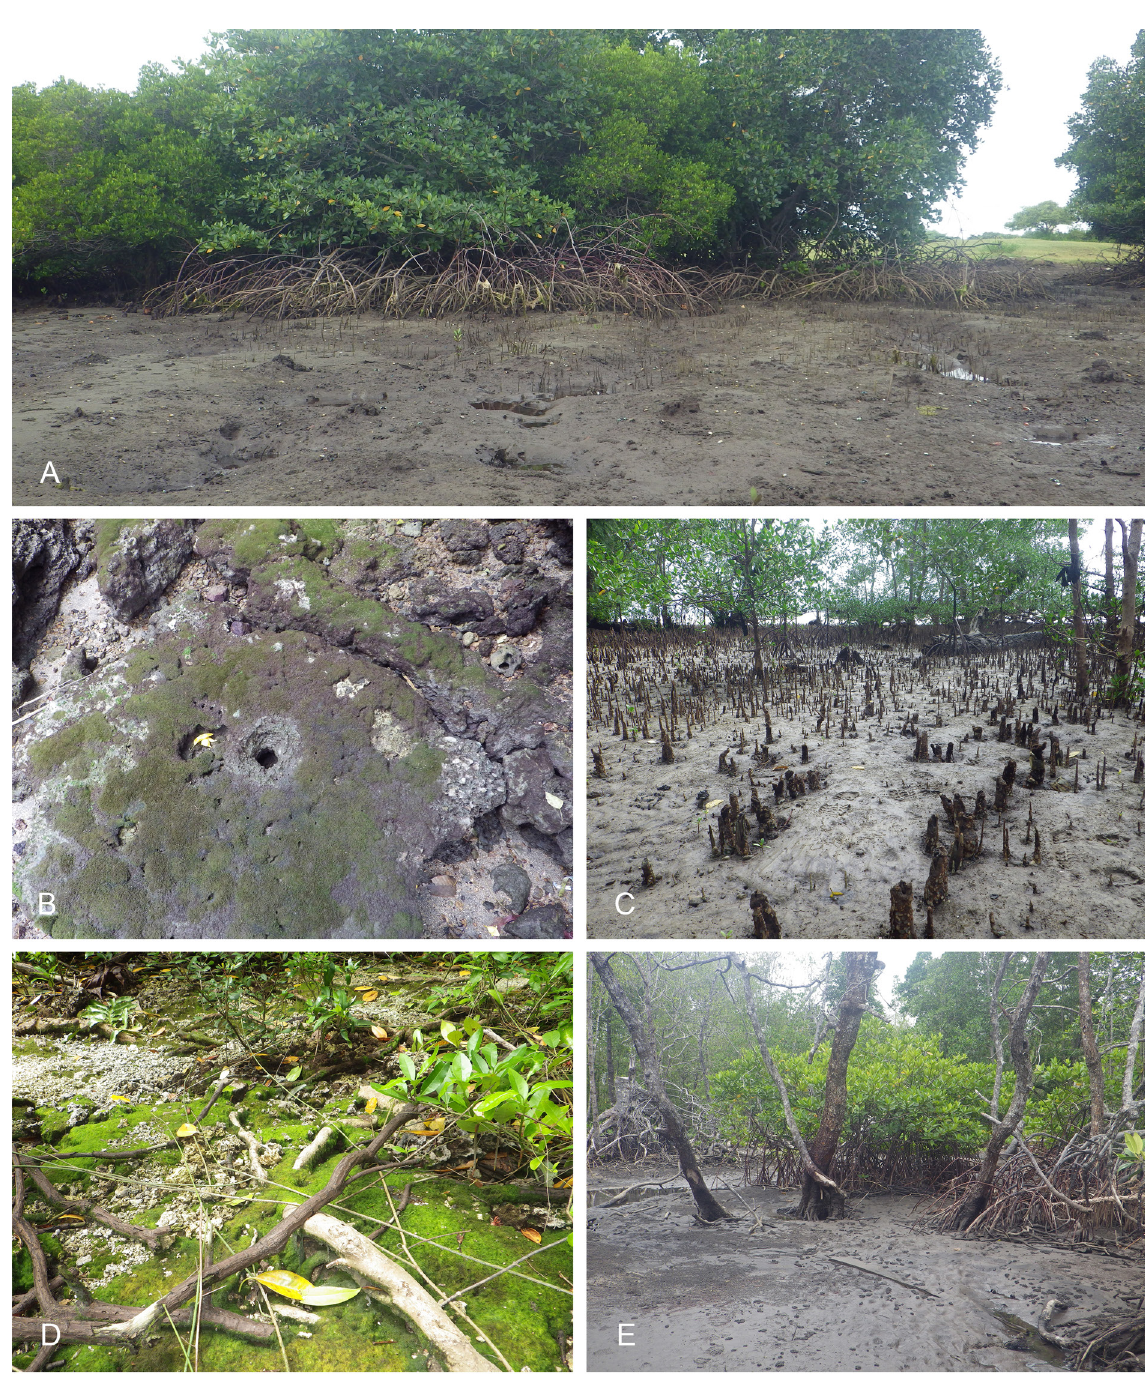
Fig. 40. Paromoionchis boholensis gen. et sp. nov., unit #2, habitats. A . Indonesia, Bali, muddy mangrove with Rhizophora and Avicennia trees (station 156). B . Indonesia, Sulawesi, sand, small rocks and pieces of wood outside a narrow coastal mangrove (station 88). C . Indonesia, Ambon, narrow band of old Avicennia trees on sandy mud, with old logs on ground (station 132). D . Indonesia, Kei, back of mangrove with rocks, mud, logs and leaf litter (station 140). E . Indonesia, Halmahera, mostly Rhizophora , with some sandy areas and some open muddy areas (station